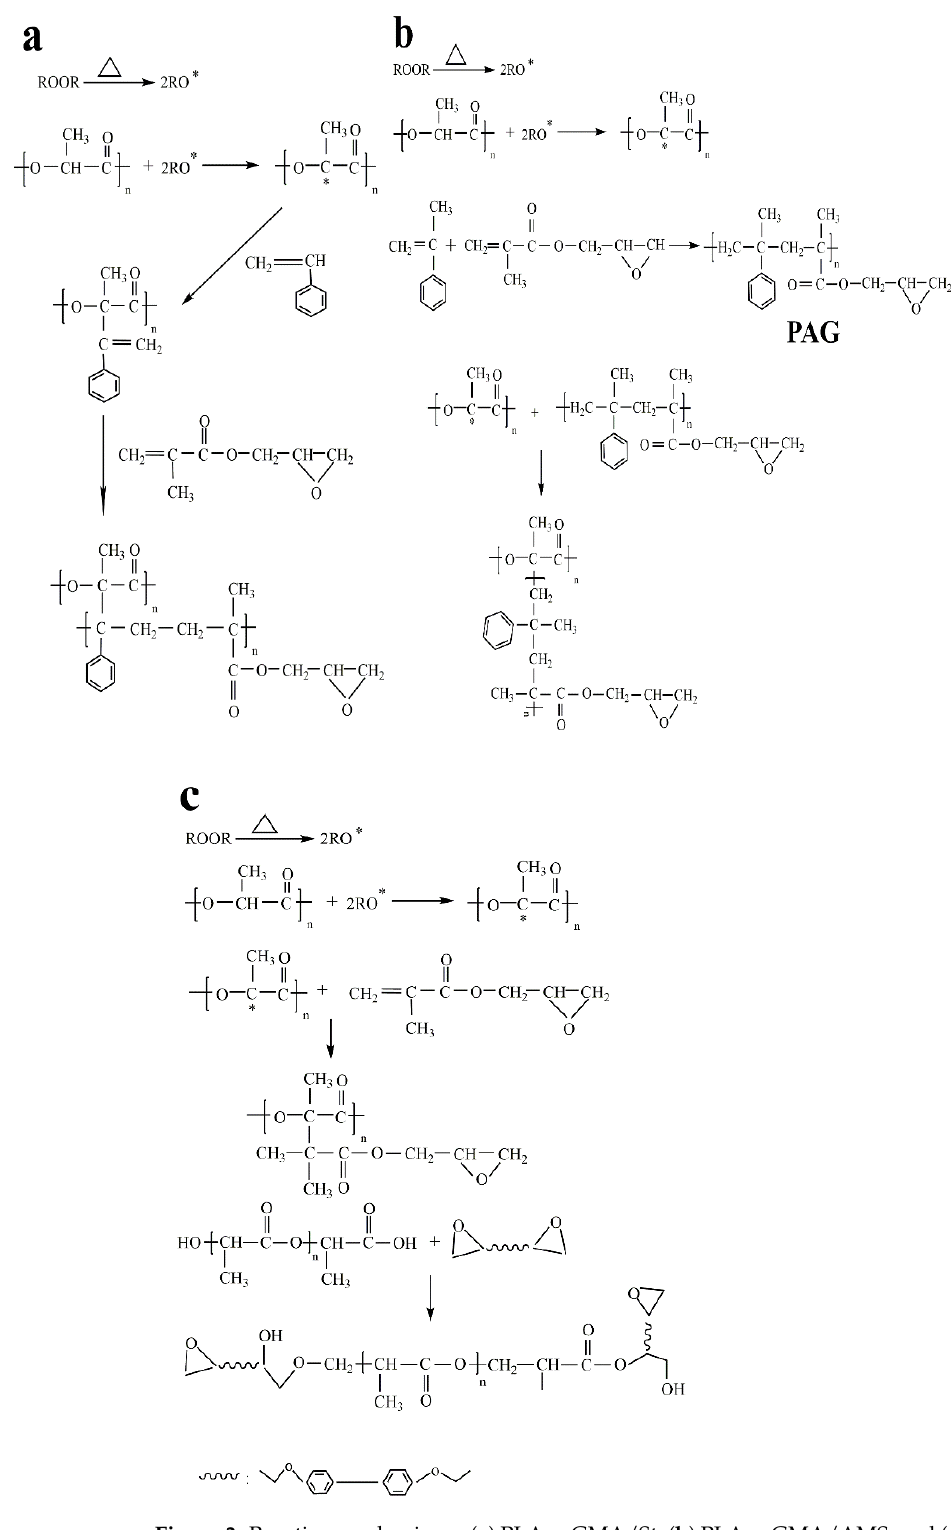
Figure 3. Reaction mechanisms: ( a ) PLA-g-GMA/St, ( b ) PLA-g-GMA/AMS, and ( c ) PLA-g-GMA/EP.